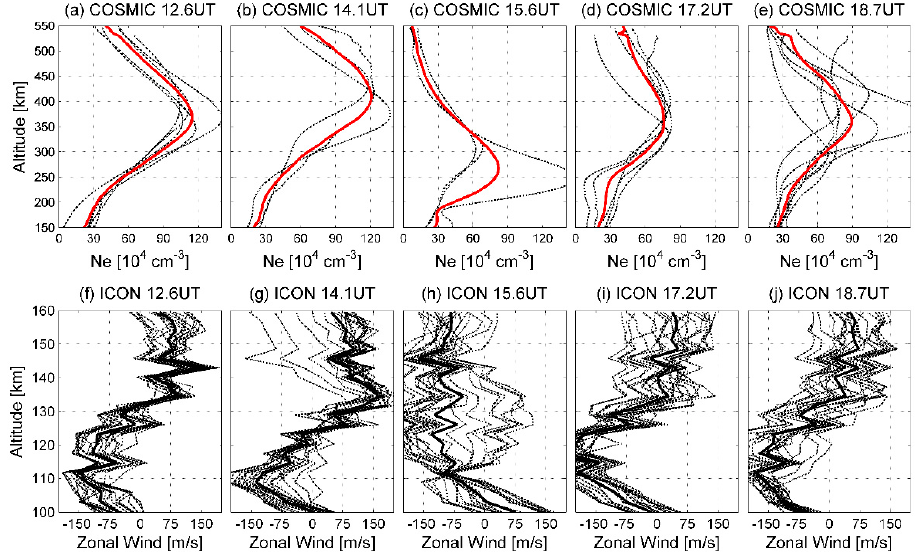
Figure 3. The vertical profile of ( a – e ) COSMIC-observed Ne in the Southern EIA and ( f – j ) ICON- observed zonal winds. ( a – e ) Black dotted and red solid lines are all profiles of selected Ne and the average profile of Ne, respectively. ( f – j ) The zonal winds are given in m/s (positive for eastward).